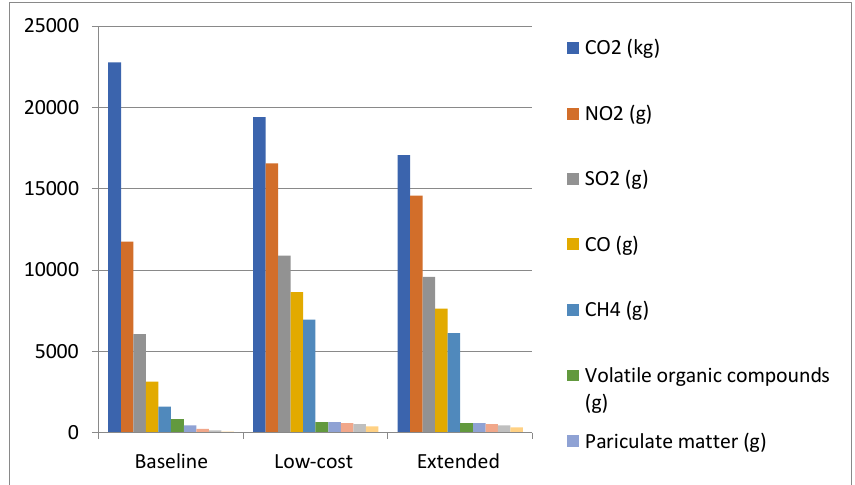
Figure 5. Environmental impacts - Algiers